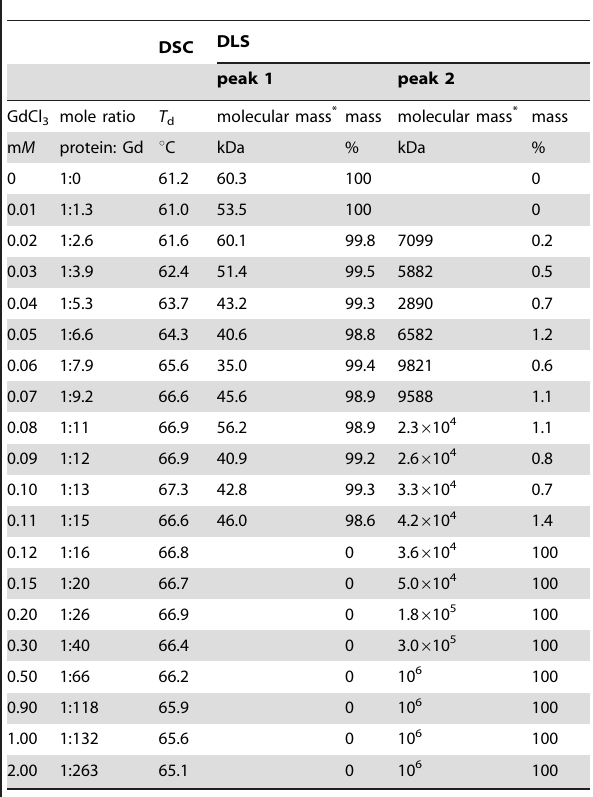
Table 1. Results of DSC and DLS experiments for 0.4 mg/mL Ao a -amylase in the presence of Gd ions at pH 5.8.